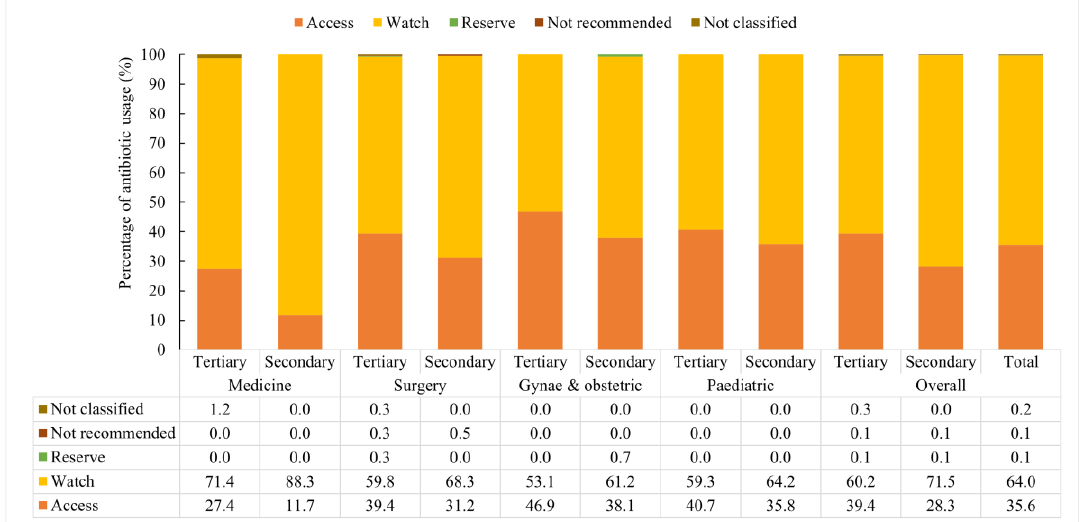
Figure 2. Antibiotics usage according to the WHO AWaRe classification at different departments of tertiary and secondary level hospitals in Bangladesh from February to April 2021 .